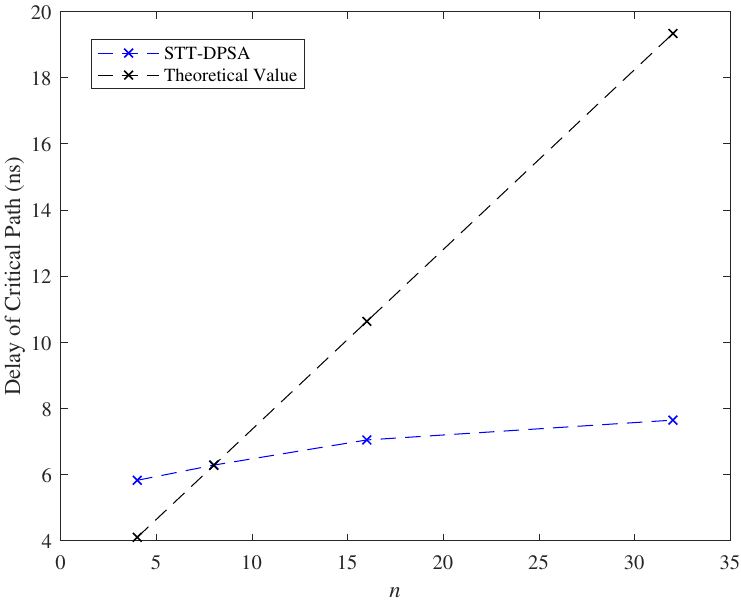
Figure 15. Effect of the parameter n with respect to the delay of critical path.